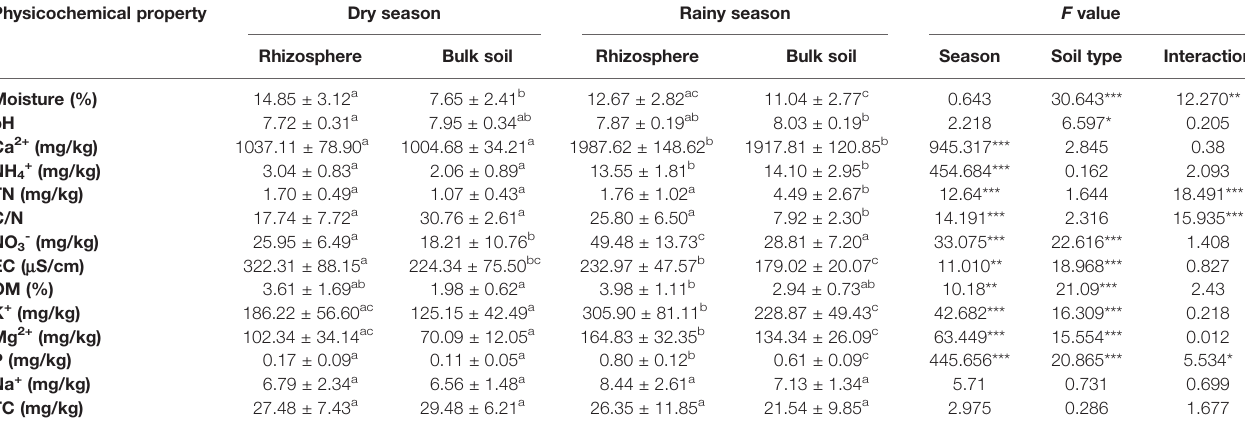
TABLE 1 | Average and standard error values obtained from physicochemical properties of Agave lechuguilla rhizosphere and bulk soil in the interspaces. Physicochemical